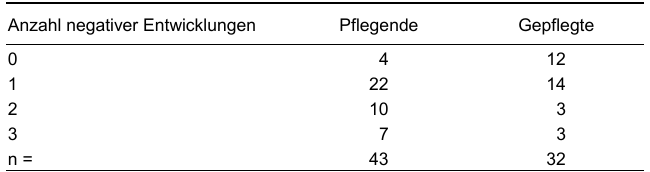
Tabelle 4 : Negative Veränderungen der Partnerschaft im Rahmen der Pflege (mehrere Antworten waren